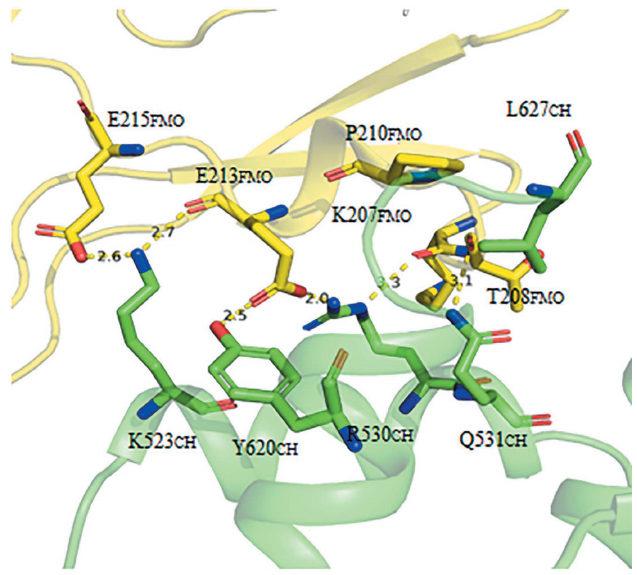
Figure 2 Binding site between the CH domain and the FMO domain in human MICAL3. Residues that participate in the interaction between the FMO and CH domains are labeled. The FMO domain is shown in yellow and the CH domain is shown in green. The binding residues between the FMO domain and the CH domain in human MICAL3 are shown as stick models. The dotted lines indicate the interaction distances between residues.